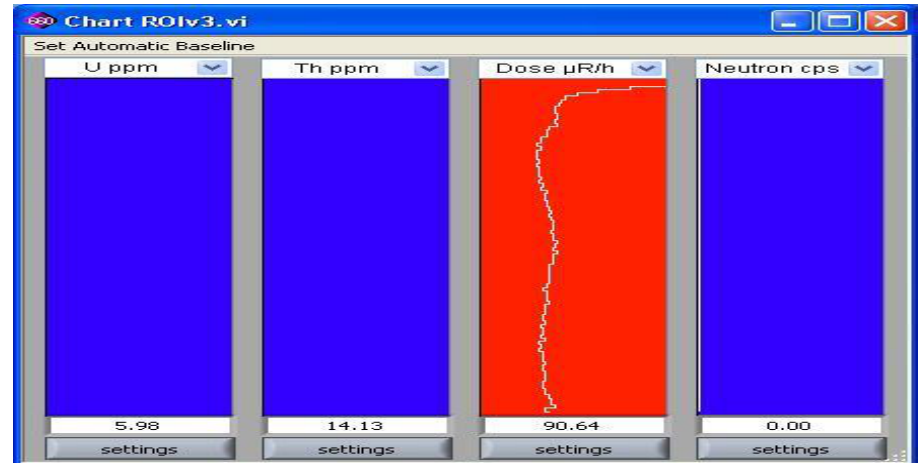
Fig.8: Readings of GR-460 system for radiation dose rate when the high activity was